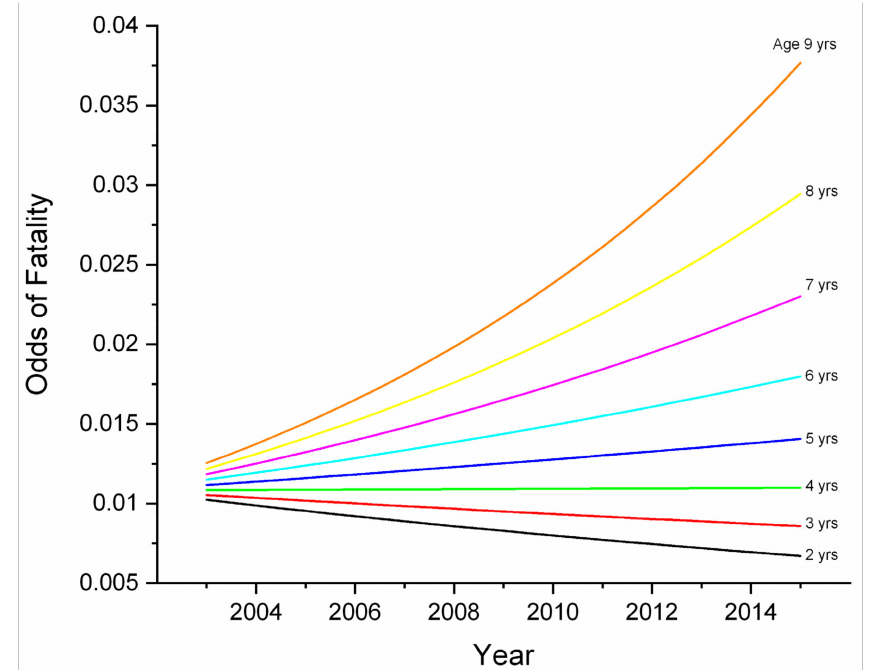
Figure 1. Odds of fatality by age and year for combined race-event and workout-event data for Ontario Thoroughbred racehorses for the period 2003–2015, unit of interest—work-event. This graph describes an AGE*YEAR interaction identified in multivariable logistic regression modelling of fatalities. For aged horses, odds increased over the study period, but for young horses, odds actually declined. This may be a reflection of increasing economic pressures throughout the study